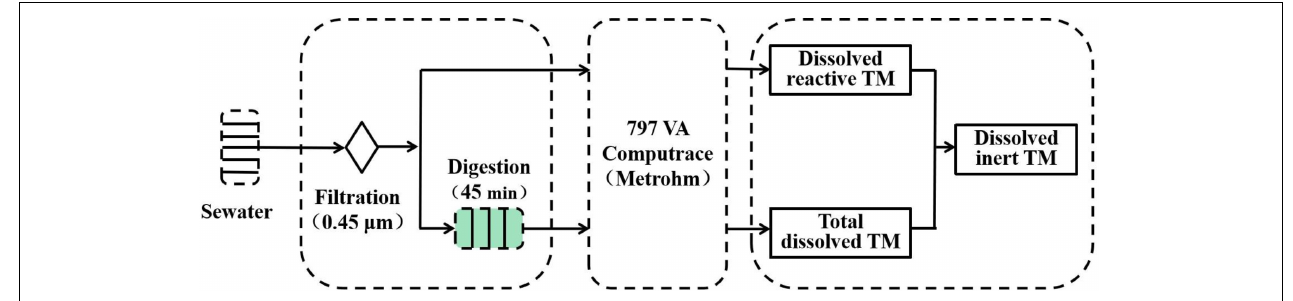
FIGURE 2 | Diagram showing the speciation analysis processes for trace metals